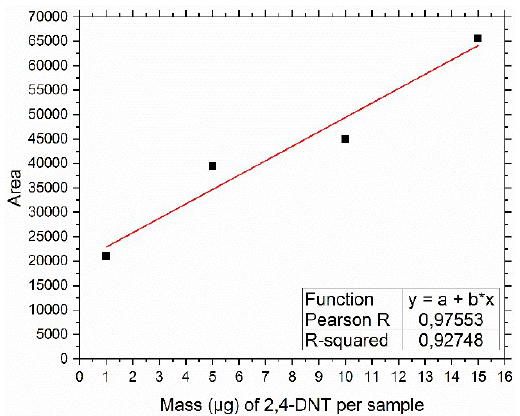
Figure A5. Calibration row for the detection of gaseous 2,4-DNT using GC-MS as stated in Material and Methods 2.10.